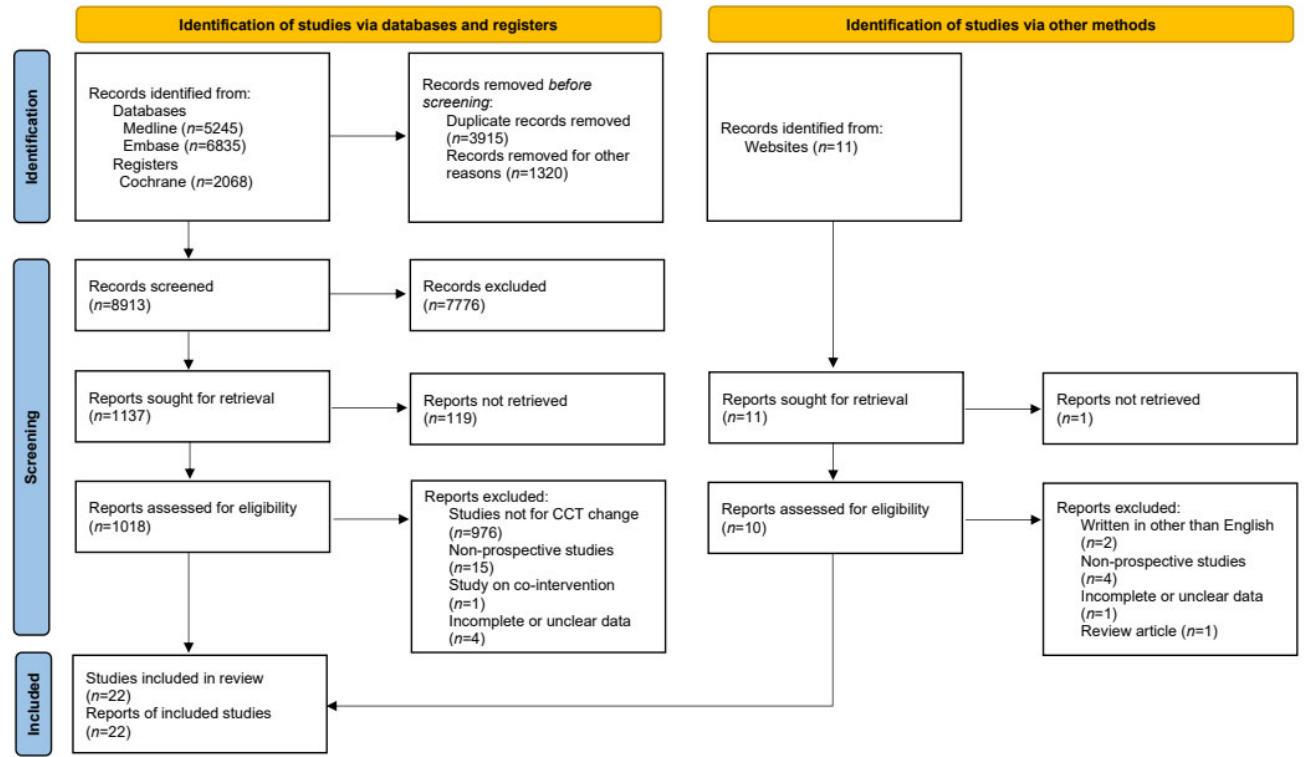
Figure 1. PRISMA 2020 flow diagram of the literature search process for identifying studies. CCT—central corneal thickness.